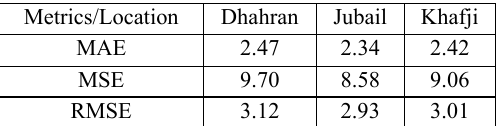
Table 3. Error metrics in Case III. Metrics/Location